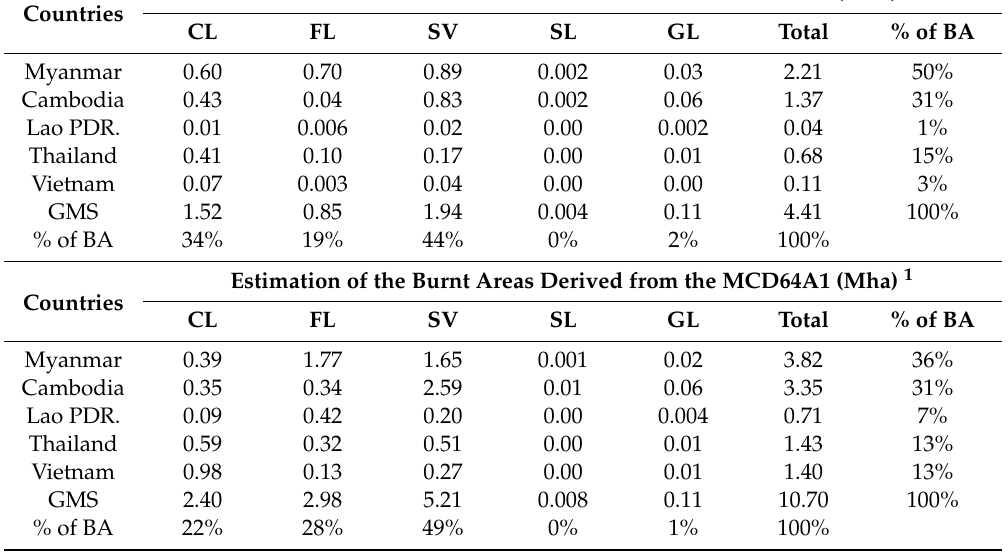
Table 3. General results of the estimation of the burnt areas derived from the MCD45A1 and MCD64A1 in the GMS classified by vegetation fires in